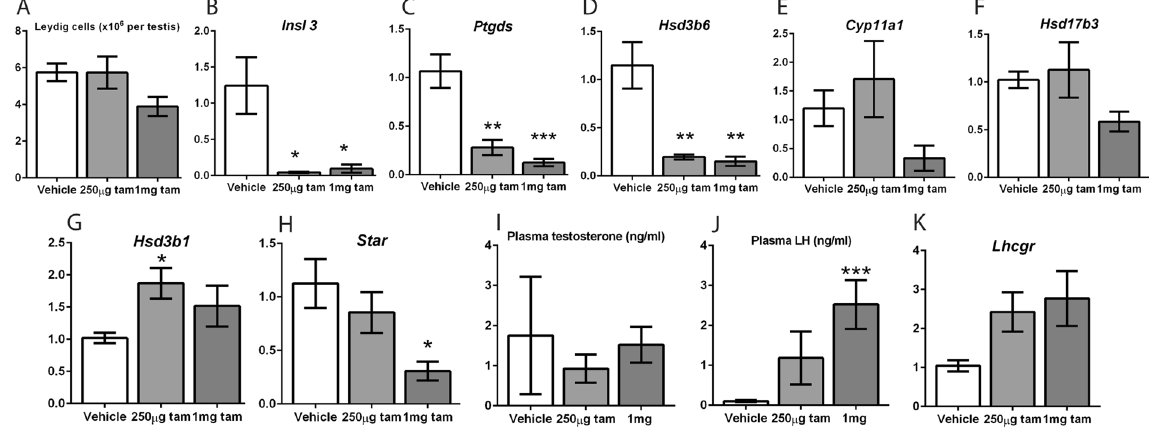
Figure 6. A single dose of 1 mg tamoxifen at d16 alters Leydig cell maturation and function in adulthood. ( A ) Leydig cell number per testis at 7 weeks was not significantly different to controls in both 1 mg and 250 µ g INYF mice tamoxifen-treated mice (n ≥ 5, error bars are SEM). Expression of the maturation markers ( B ) Insl3 , ( C ) Ptgds and ( D ) Hsd3b6 is significantly decreased in both doses of treated mice compared to vehicle controls. Expression of the steroidogenic enzyme genes ( E ) Cyp11a1 and ( F ) Hsd17b3 are unchanged in